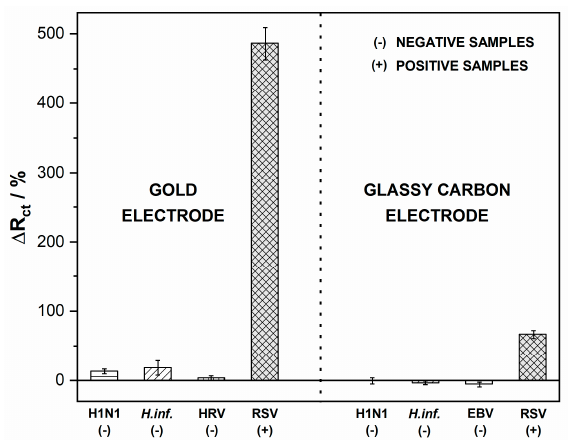
Figure 6. Impedance spectra recorded after incubation with RSV and interfering pathogens. Registered in 5 mM K 3 [Fe(CN) 6 ]/K 4 [Fe(CN) 6 ]/0.01 M PBS, the incubation time was 5 min. Error bars denote confidence interval ( α = 0.05, n = 3).